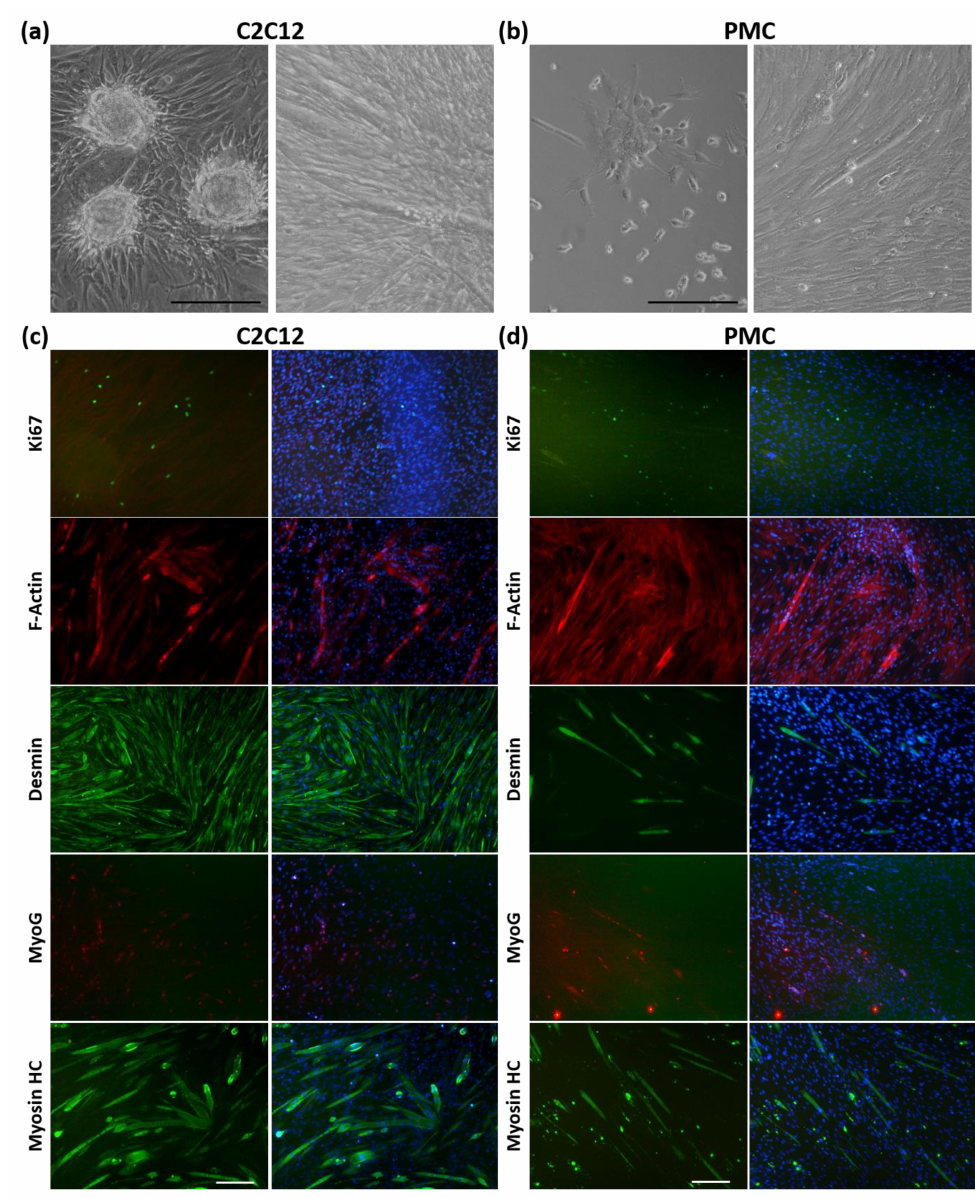
Figure 5. Myogenic differentiation of cells outgrown from myospheres. After 5 days of cultivation, spheroids were seeded, allowed to adhere, and C2C12 cells ( a ) as well as PMCs ( b ) were able to outgrow and form myotubes. For the differentiation assay ( c , d ), a single cell suspension was obtained from spheroids and cells were allowed to undergo myogenic differentiation in 2D culture. Subsequent immunofluorescence staining revealed proliferating (Ki67) and differentiating (MyoG) cells, as well as expression of the filament proteins F-Actin or Desmin. Multinuclear myotubes were formed by C2C12 ( c ) and PMCs ( d ) expressing Myosin heavy chain (HC). Right panel shows merged images with DAPI staining. Scale bar: 200 µ